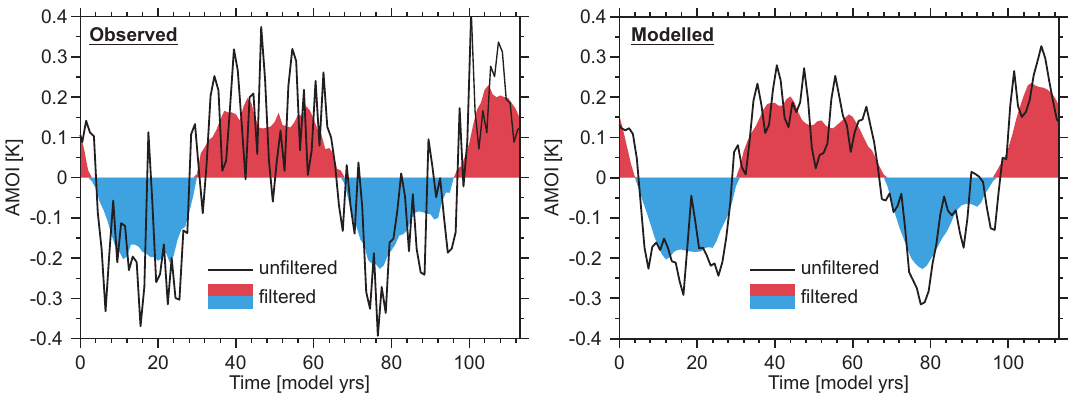
Fig. 1. Observed and modelled AMO index, pre- (lines) and post- (shaded) low-pass filtering (10 year moving average). Positive and negative phases of the AMO are shown by red and blue shading,